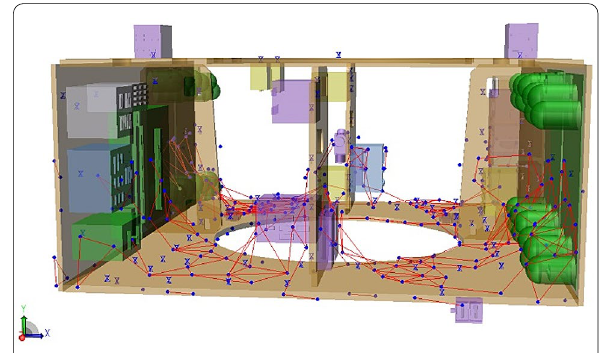
Figure 14 Roadmap in the second scenario